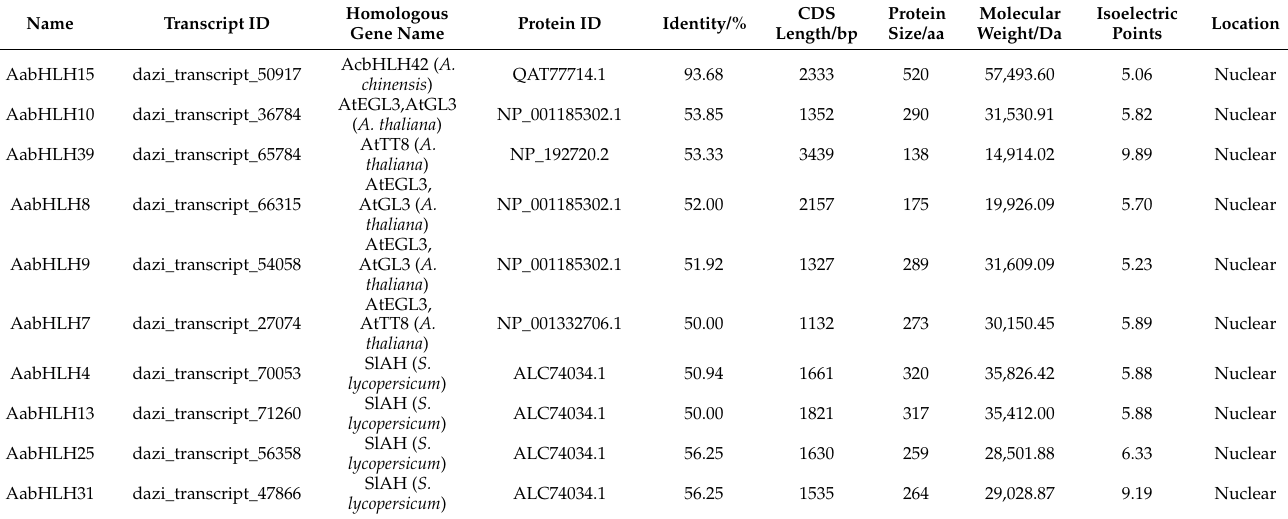
Table 3. Details of candidate anthocyanin biosynthesis-related AabHLH gene family in A. arguta cv.